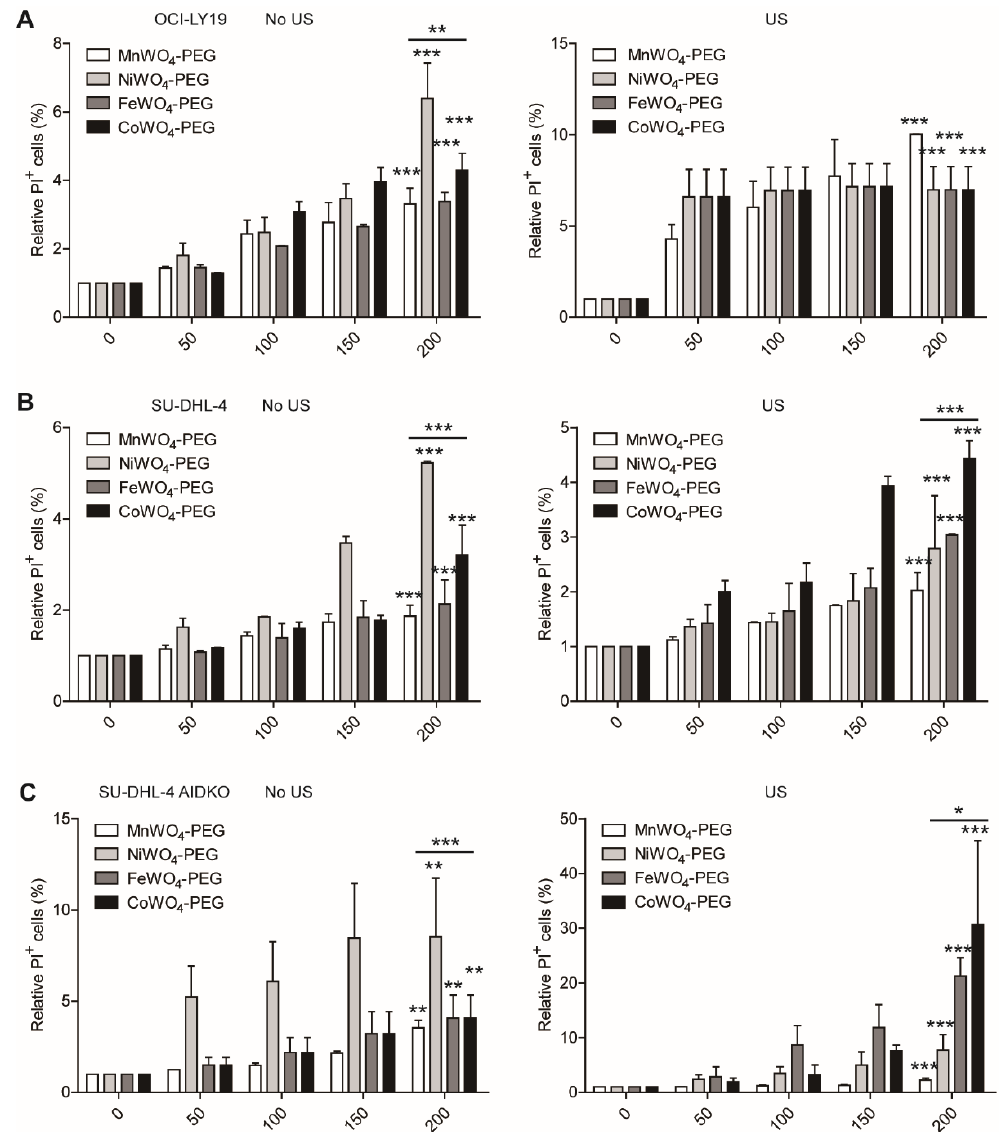
Figure 7. US-triggered toxicity of MWO 4 -PEG NPs. The relative apoptosis rate of human OCI-LY19 ( A ), SU-DHL-4 ( B ), and AIDKO SU-DHL-4 ( C ) cells treated by increasing concentration (0, 50, 100, 150, 200 μ g/mL) of four MWO 4 -PEG NPs with (left figure) or without (right figure) US irradiation. The propidium iodide (PI) was used to stain the NPs treated DLBCL cells to indicate apoptosis cells. The percentage of PI + cells was detected by flow cytometry. The data shown are representative of 3 independent experiments. Data are represented as mean ± SD. *, ** and *** represent p < 0.05, p < 0.01 and p < 0.001, respectively.